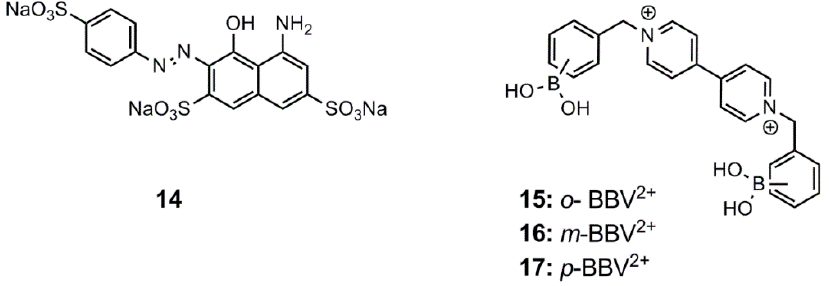
Figure 4. Singaram’s viologen arylboronic acids, 15 – 17 , employed by Feng and co-workers, using azo compound 14 as the fluorescent dye